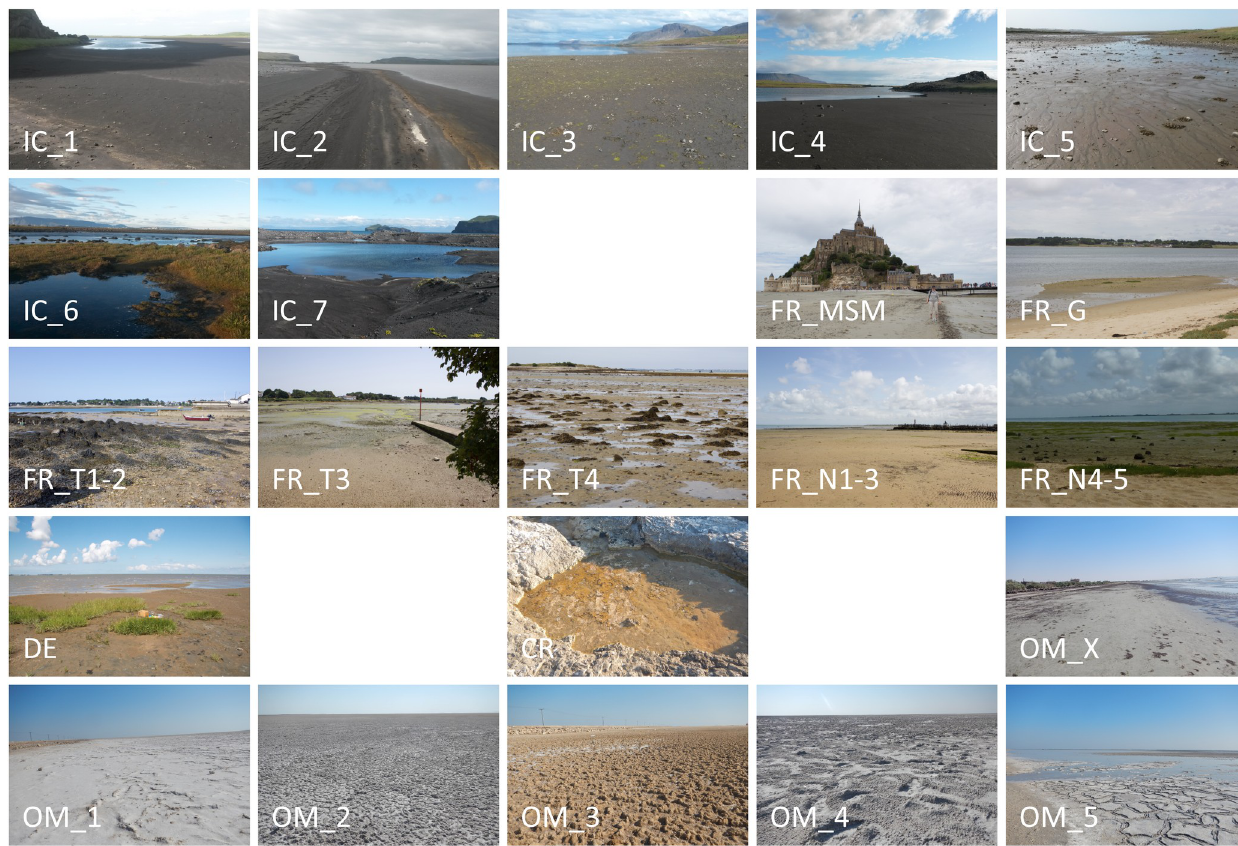
Fig 1. Pictures of all sampling sites. CR = Croatia, FR = France, DE = Germany, IC = Iceland, OM = Oman.